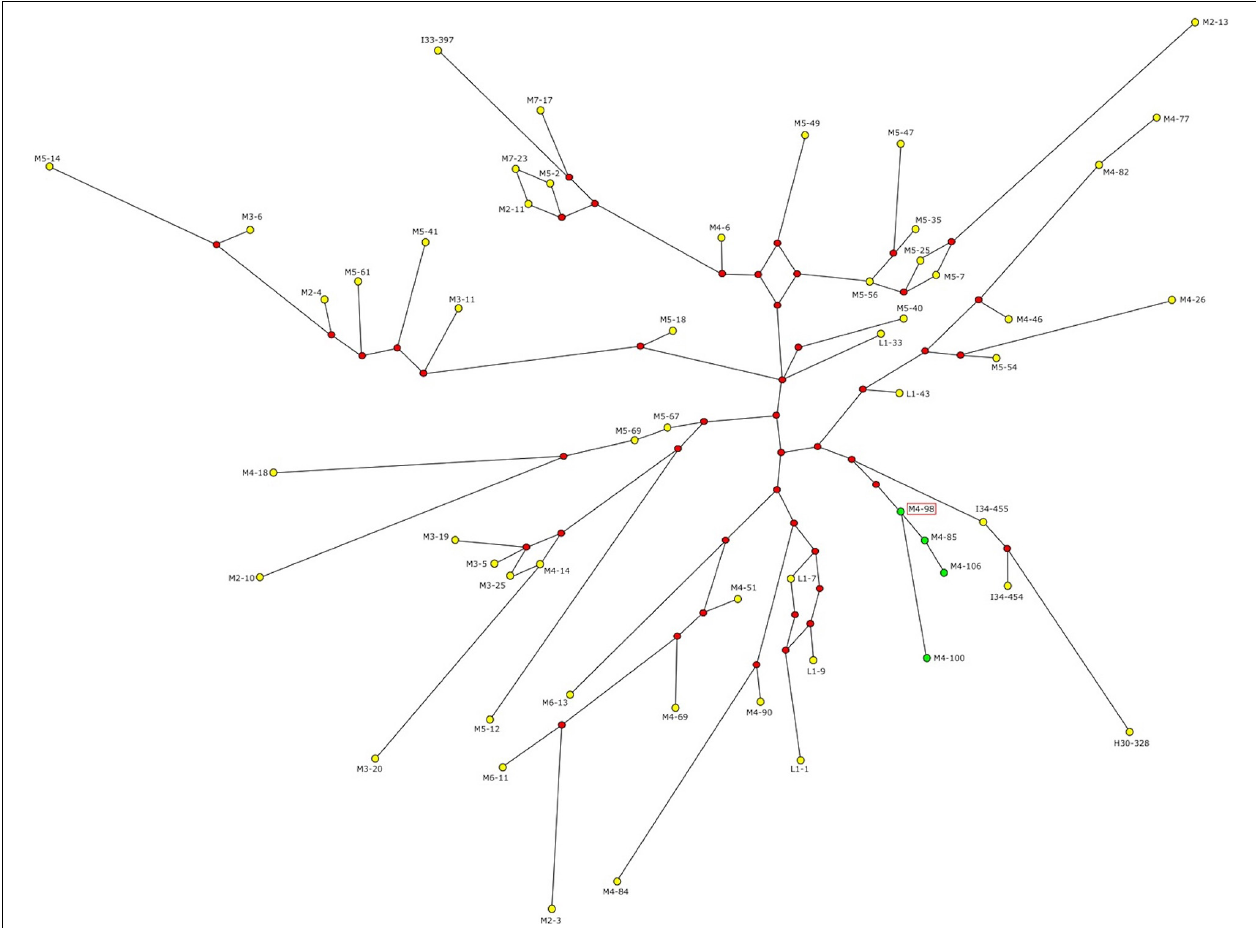
FIGURE 3 | Network representing the relationship between R1b and V69 subjects. Green dots represent the four subjects carrying the genomic rearrangement, yellow dots all the remaining R1b-V69 subjects (dot area is proportional to the haplotype frequency). Red dots represent the median nodes of the network. The sequenced sample is highlighted by a red frame. Time estimates in years obtained with the ASD